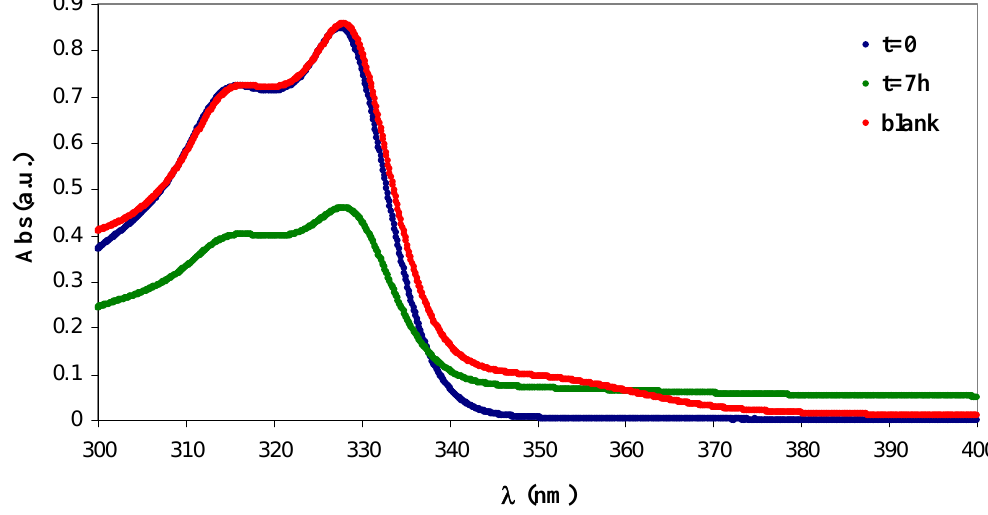
Figure 8. UV-Vis spectra of β -naphthol (BN) aqueous solutions. Blue : [BN] = 5 × 10 − 4 M before the addition of cellulose. Green : 7 h after the addition of H . Red : 24 h after the addition of α -cellulose D .